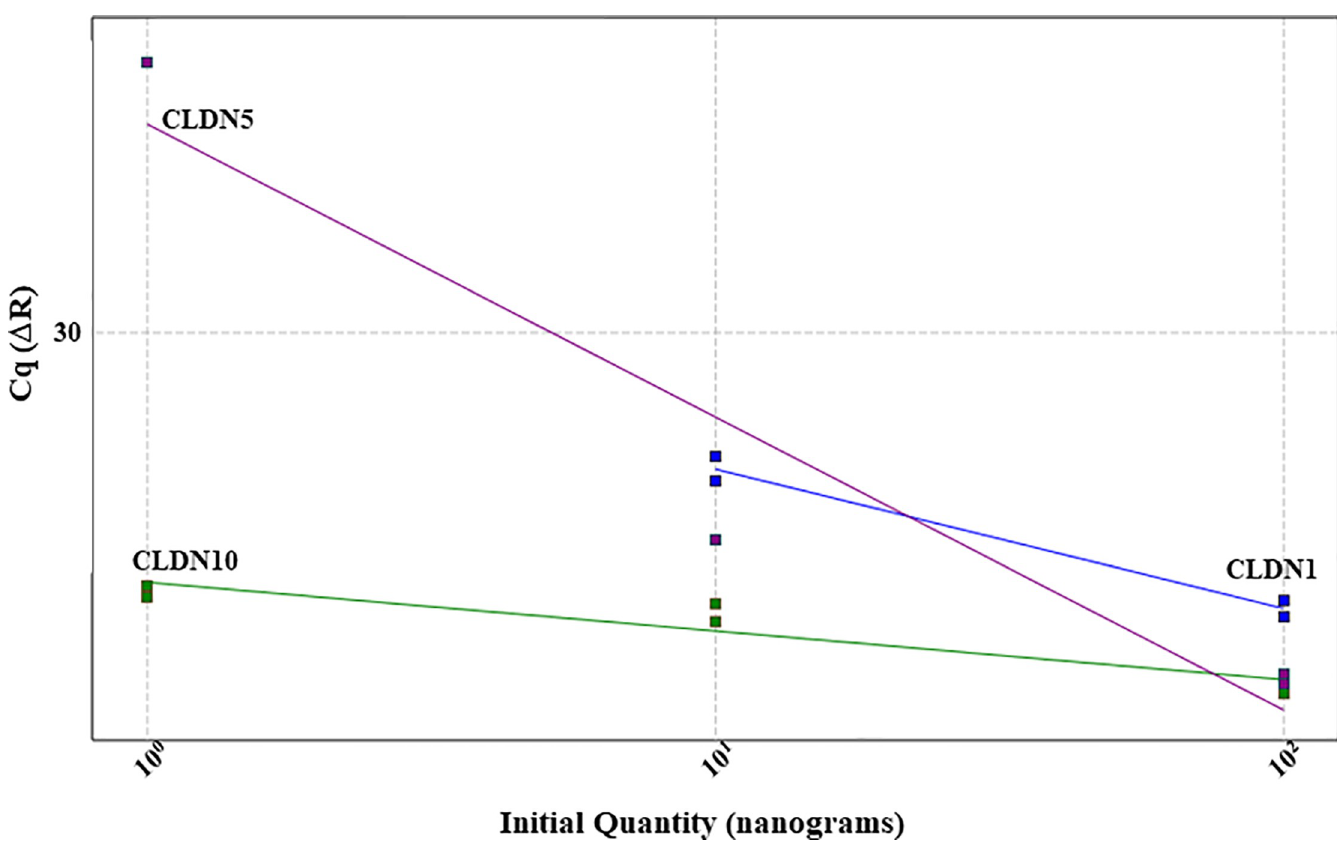
Fig 3. Standard curves of CLDN1, 5 and 10 in a multiplex RT-qPCR assay. Primers and/or probe of CLDN10 are interfering with CLDN1 and 5, indicated by not proportional and not linear standard curves.